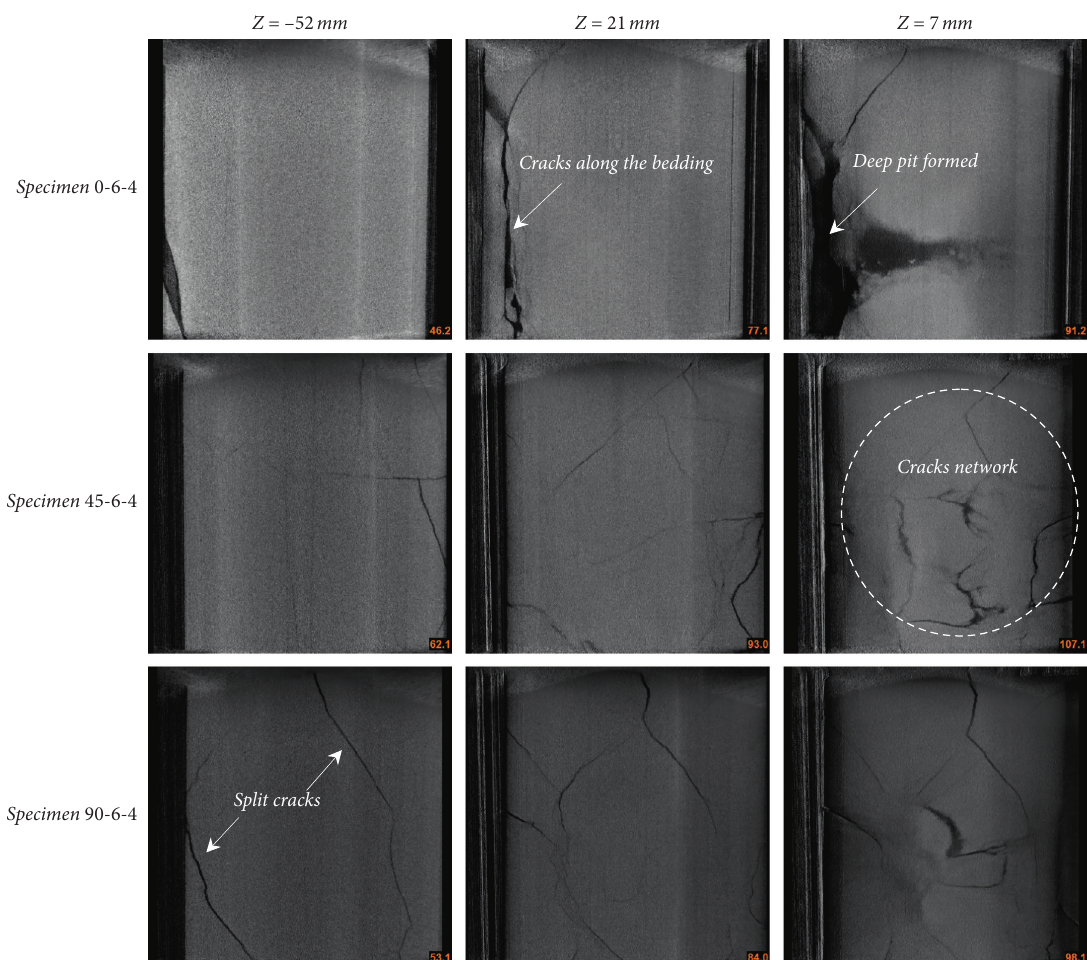
Figure 14: CT images in the Z plane for the α � 0 ° , 45 ° , and 90 ° specimens under a maximum principal stress of